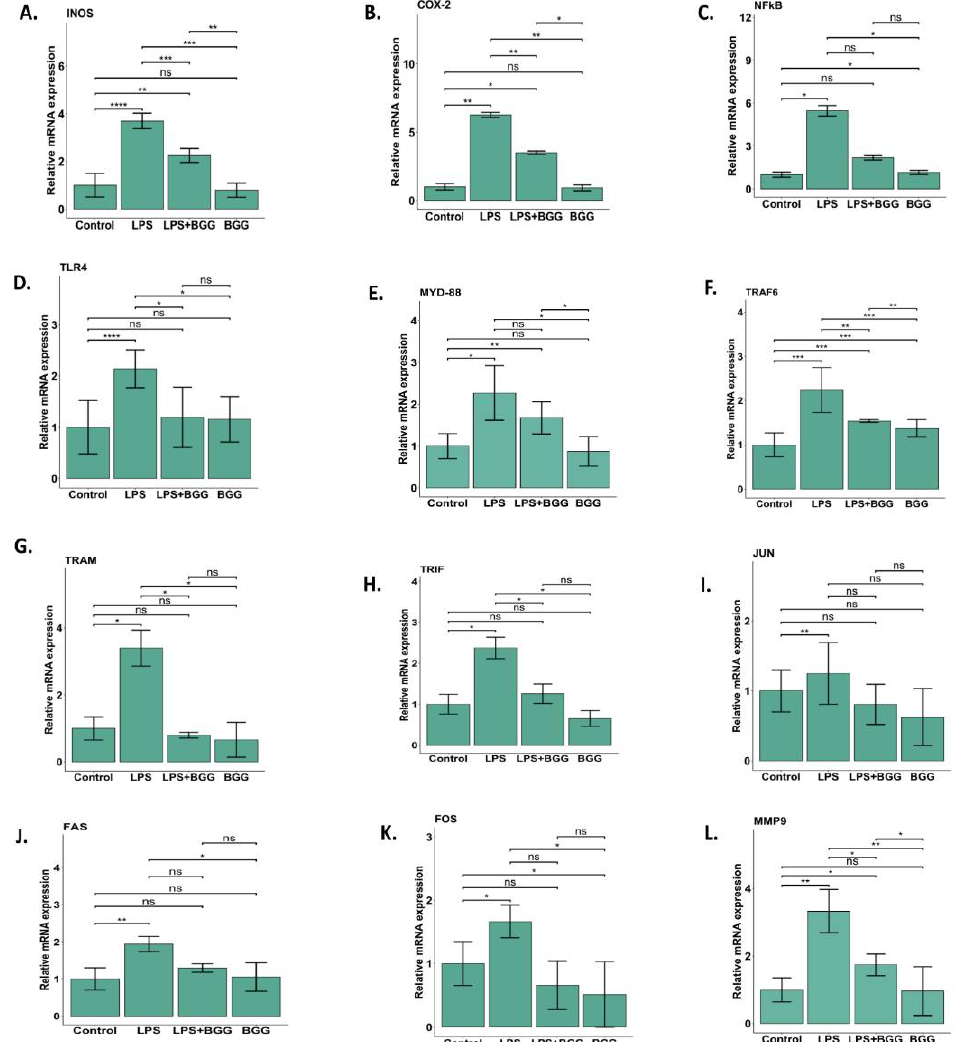
Figure 8. Validation of the gene profiling data, RAW 264.7 cells were pre-treated with BGG (10 µ M) for 1 h, followed by LPS (1 µ g/mL) stimulation for 23 h. Total RNA was isolated by using TRIzol reagent; the isolated RNA was subjected to cDNA synthesis, and SYBERgreen was used for amplification. The qPCR confirmed cell death, immune system, and metabolic process pathway genes. Actin was used as a housekeeping gene. Results are mentioned as mean ± SD ( n = 3), p -value ≤ 0.05, (* p ≤ 0.05, ** p < 0.001, *** p < 0.0001, and **** p < 0.00001). ( A – L ) (ns: not